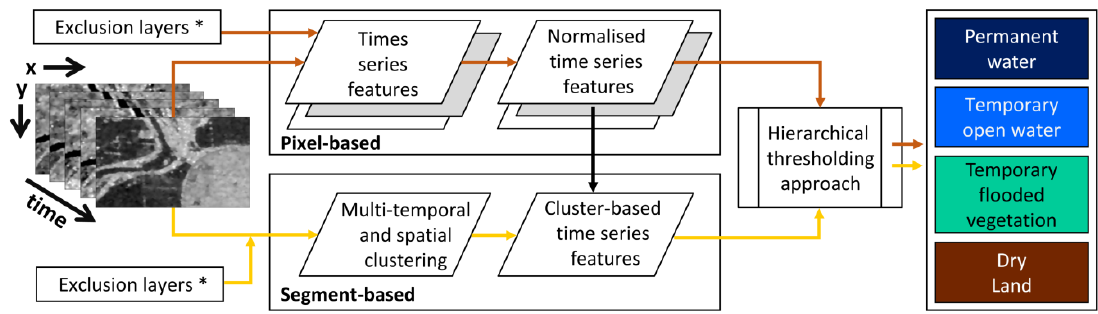
Figure 4. Classification process chain for the extraction of temporary open water and temporary flooded vegetation based on SAR time series data. The deep orange arrows represent the pixel-based process part, while bright orange arrows show the object-based part of the process chain. * Global Urban Footprint (GUF), Height above Nearest Drainage (HAND) index, and SRTM Water Body Data (SWBD) as exclusion layers.